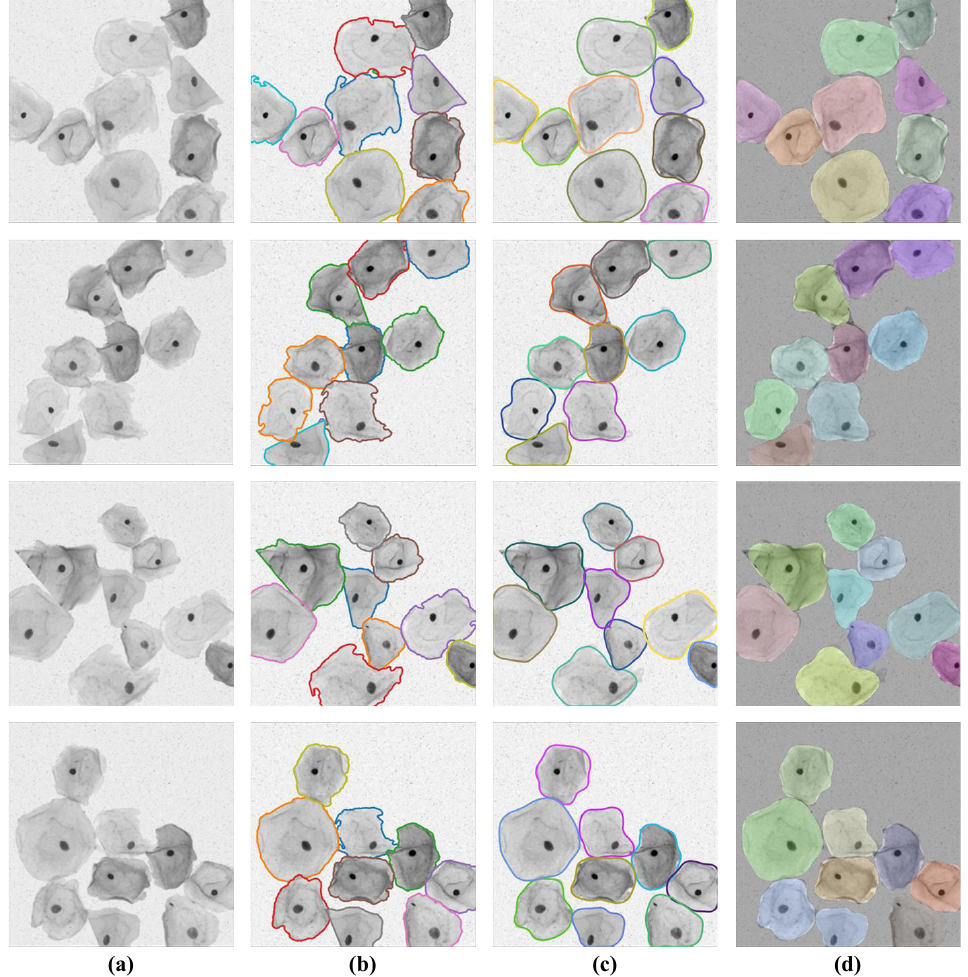
Figure 6. Segmentation results of our SPCNet on the TCC dataset. ( a ) Sample images and ( b ) the corresponding ground truths. ( c ) Predicted results and ( d ) the segmented instances based on random color